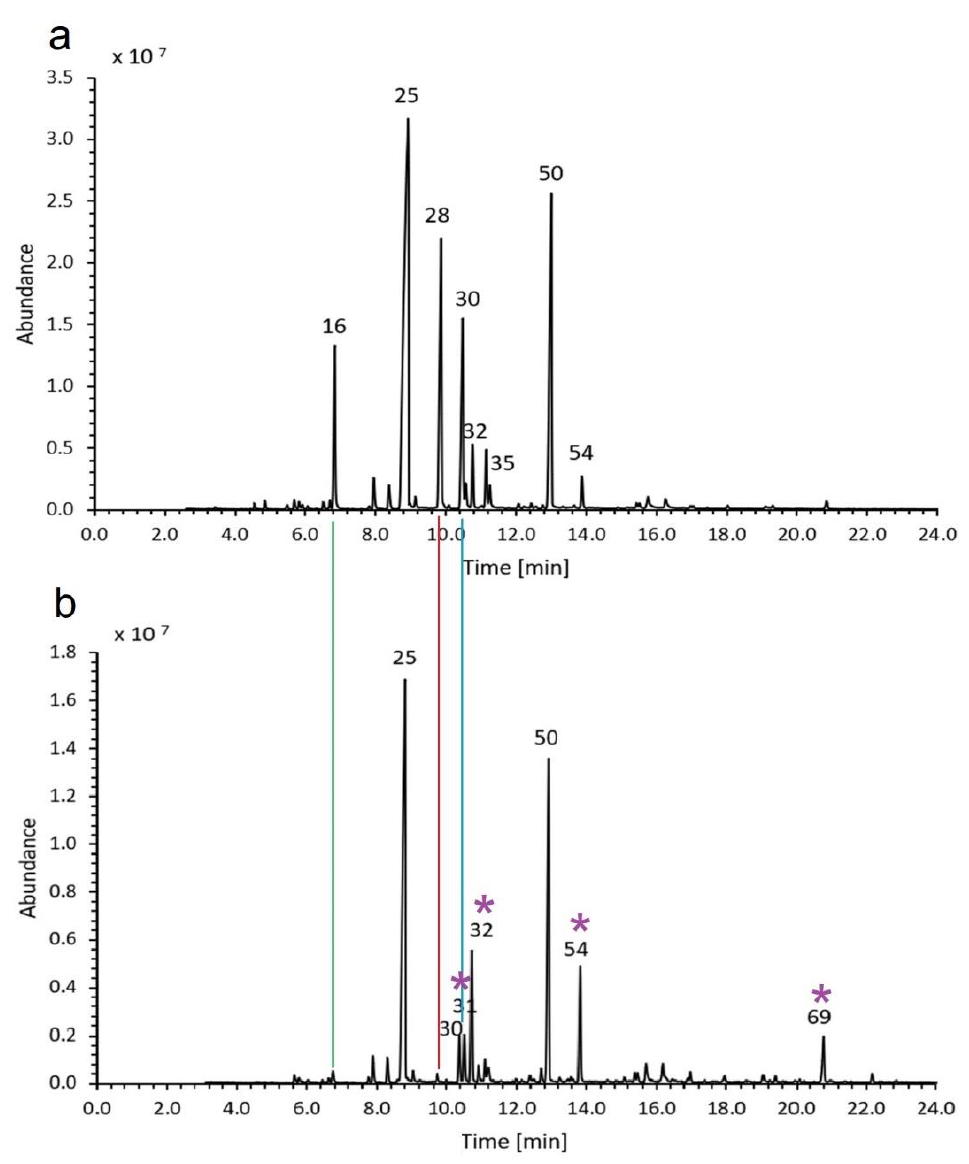
Figure 4. Exemplary chromatograms of lavandin (( a ), sample ID 226) and true lavender (( b ), sample ID 452) essential oil. The peaks were numbered according to Tables 2 and 4. The lines illustrate which components were more abundant in lavandin oil: eucalyptol (green), camphor (red), and borneol (blue). The asterisks highlight which components were more abundant in true lavender oils (lavandulol, terpinen-4-ol, lavandulyl acetate, and caryophyllene oxide).